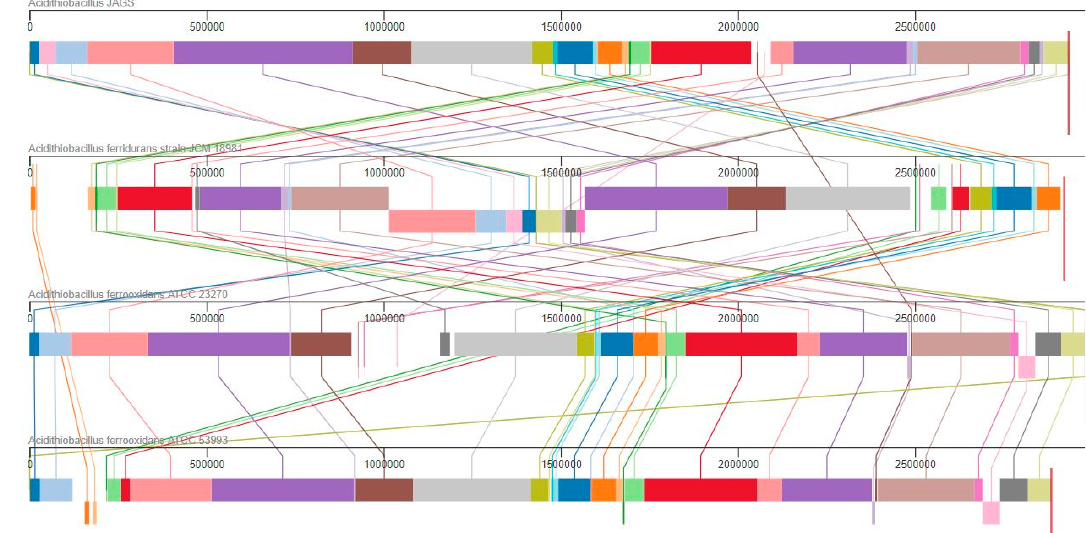
Figure 2. Whole-genome alignment of A. ferridurans JAGS, A. ferridurans JCM18981, A. ferrooxidans ATCC53993 and A. ferrooxidans ATCC23270. Locally collinear blocks (LCBs) identified by Mauve are color-coded; links between LCBs are indicated by the thin colored